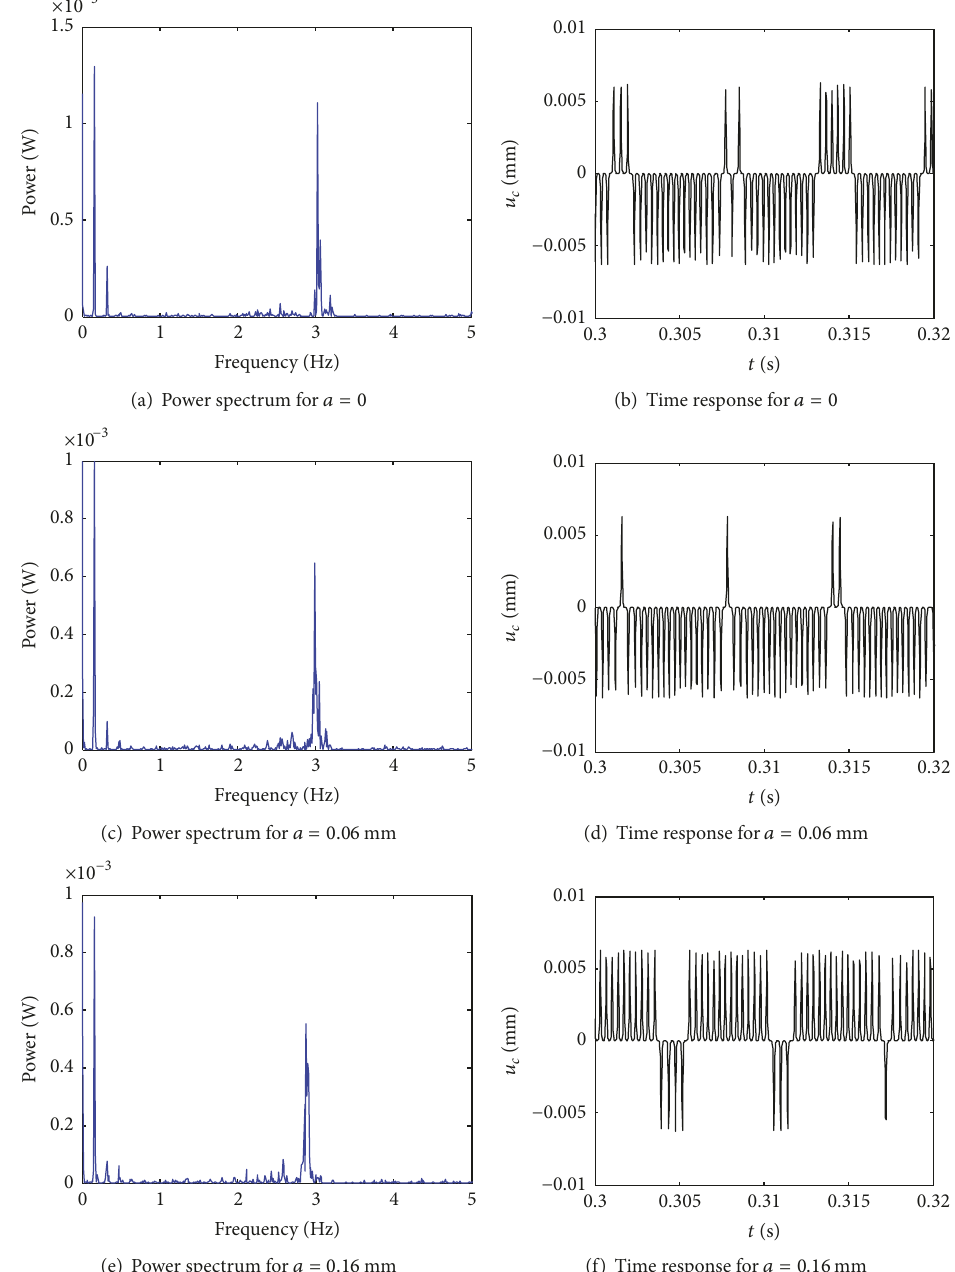
Figure 17: Power spectrum and time response of rigid cog for different wave generator